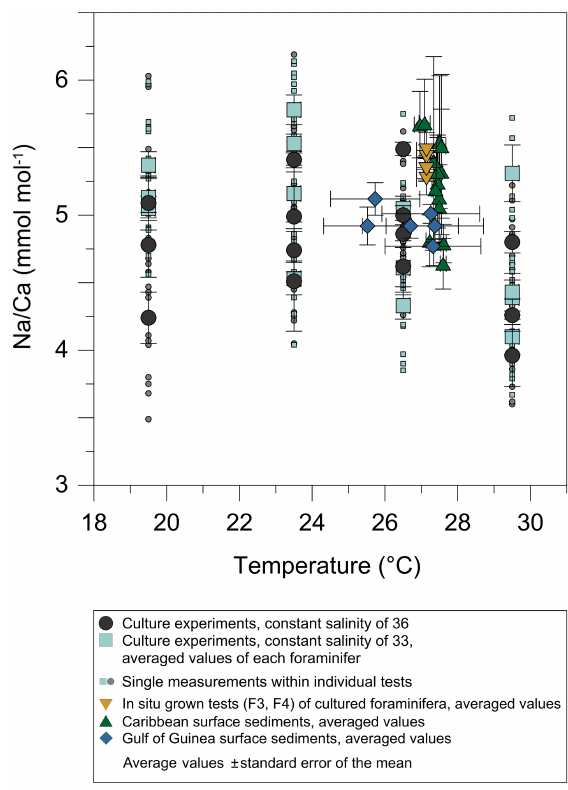
Figure 5. Na / Ca values of cultured T. sacculifer versus temper- ature show no significant correlation with increasing temperature (19.5–29.5 ◦ C ± 0.25 ◦ C) in two different settings at either a con- stant salinity of 33 ( S 33, p < 0 . 14 – grey dots) or 36 ( S 36, p < 0 . 69 – light blue squares). Each small light grey and light blue symbol comprises averaged Na / Ca values of single map electron micro- probe analysis along inner chamber wall cross sections of newly grown calcite (F, F-1) during the experiments. Bigger symbols of the same latter colors indicate averaged Na / Ca values of one foraminifer. Related data are given in Tables 4 and 5. All vertical error bars are based on the standard error of the mean. Yellow re- verse triangles indicate Na / Ca values from in situ grown chambers before culturing (annual salinity: ∼ 35 . 9, temperature: ∼ 27 . 4 ◦ C; WOA13; Table 3). Blue diamonds reflect Na / Ca values of T. sac- culifer from Gulf of Guinea surface sediments and green triangles are data from Caribbean surface sediments (Table 1). Horizontal er- ror bars of surface sediments, which are as small as the symbols for Caribbean samples, demonstrate the temperature gradient between 0 and 60m. The gradient reflects the habitat range of T. sacculifer expressed as the standard error of the